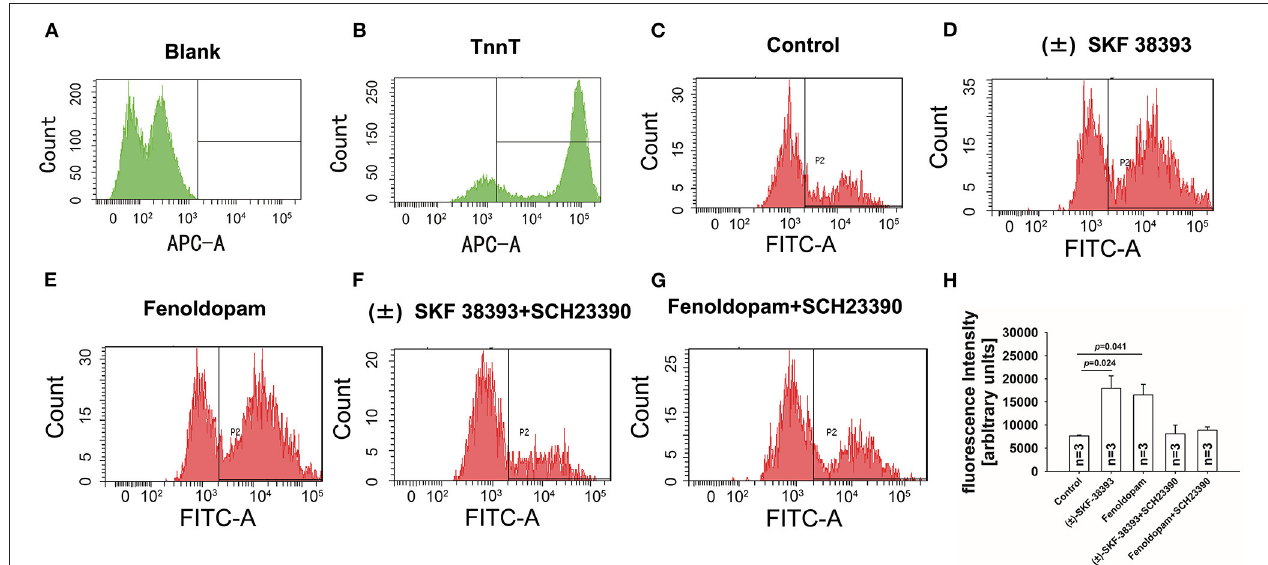
FIGURE 5 | Dopamine D1/D5 receptor activation increased ROS-production. hiPSC-CMs were treated with or without antibody against troponin T (cTnT) and ROS fluorescence dye was applied to measure ROS production. Vehicle (Control) (C) or 50 µ M ( ± )-SKF 38393 or 5 µ M fenoldopam or ( ± )-SKF 38393 plus 10 µ M SCH 23390 or fenoldopam plus 10 µ M SCH 23390 (D–G) was applied to cells for 1h before measurements. ROS-generation was analyzed by FACS. (A,B) A representative recoding indicating cardiac troponin T (cTnT) in hiPSC-CMs. (D,E) A representative recoding indicating enhancement of ROS generation by ( ± )-SKF 38393 or fenoldopam. (F,G) A representative recoding indicating that SCH 23390 prevented the effect of ( ± )-SKF 38393 or fenoldopam on ROS generation. (H) Averaged values of fluorescence intensity showing the ROS-levels in cells. “blank” means control measurements in cells that were not treated by the ROS fluorescence dye. “ n ” numbers in (H) are numbers of different independent experiments using cells from different differentiations. The p -values vs. Control were determined by the analysis of one-way ANOVA with Holm-Sidak